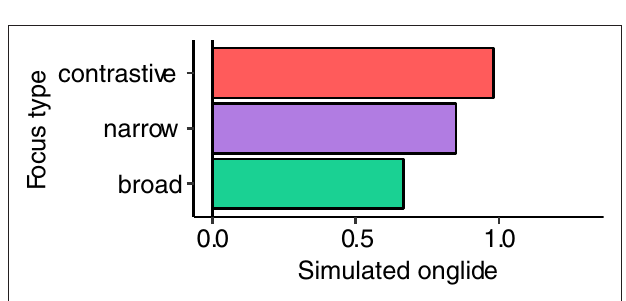
FIGURE 11 | Means of “rises”, i.e., positives values from the simulated onglide data for broad, narrow, and contrastive